Question: Write a single sentence explaining what this figure depicts.
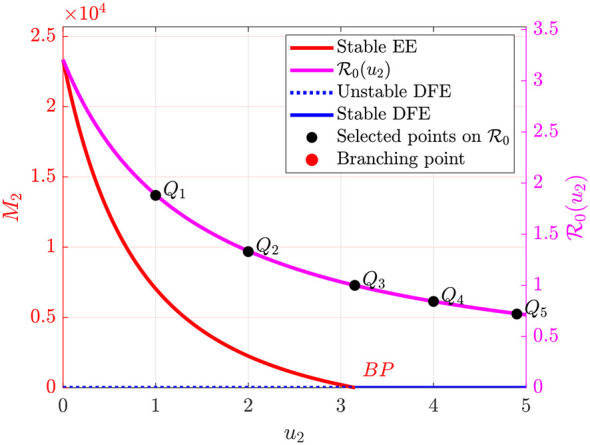
Answer: The bifurcation diagram of M 2 with respect to u 2 from model Equation 3 . The solid red, blue, and cyan curves represent the stable endemic equilibrium, the stable malaria-free equilibrium, and the basic reproduction number as a function of u 2 . BP represents the bifurcation point R 0 = 1 , while Q i at i = 1, 2, 3, 4, 5 denotes five sampling points for the autonomous simulation in Figure 11 .